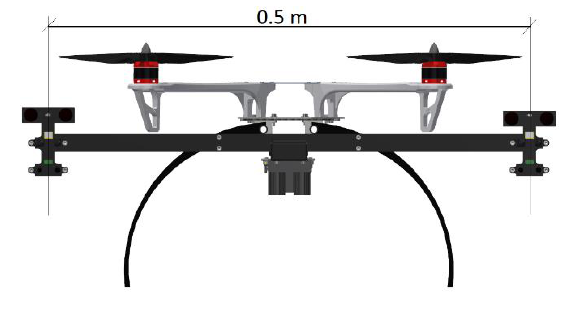
Figure 3. CAD assembly of the Payload in the UAV